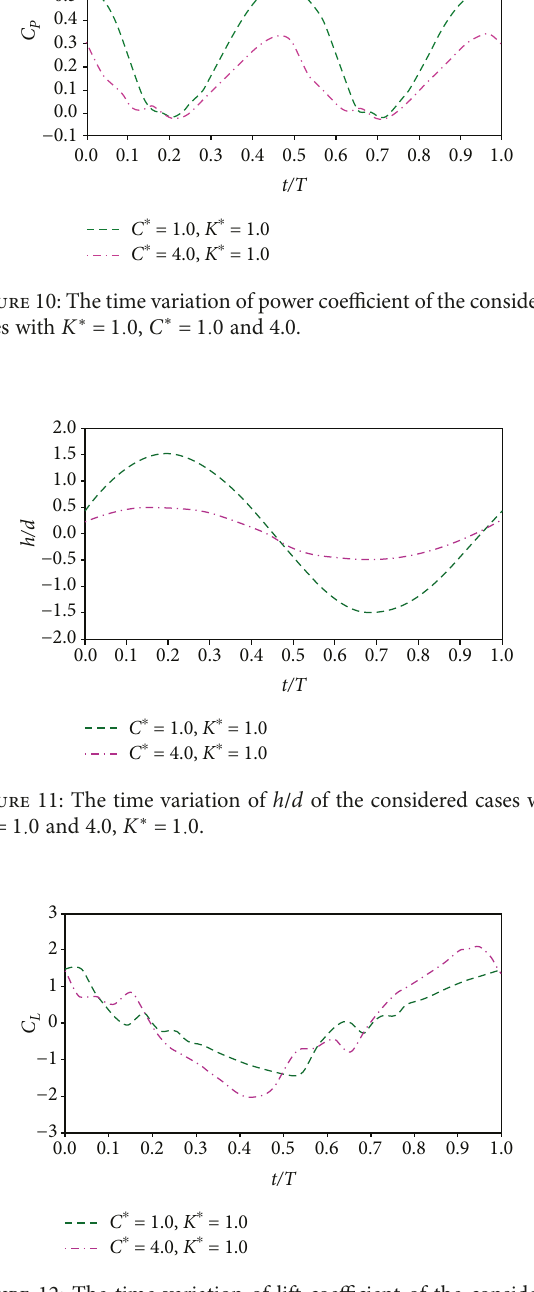
Figure 12: The time variation of lift coe ffi cient of the considered cases with C ∗ = 1 0 and 4.0, K ∗ = 1 0 .